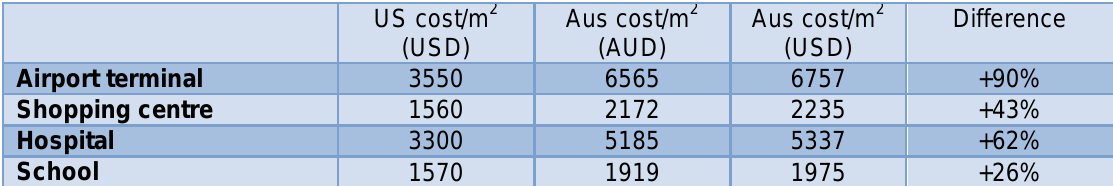
Table 1 2011: Turner & Townsend data, annual average exchange rate (0.97AUD=1USD)